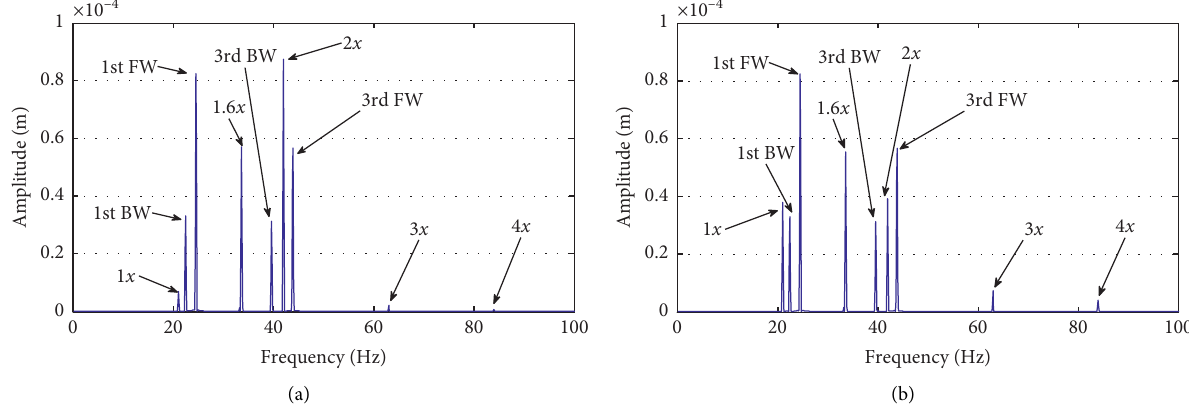
Figure 12: Spectrum of misalignment at bearing 4 (outer rotor): (a) horizontal direction and (b) vertical direction.